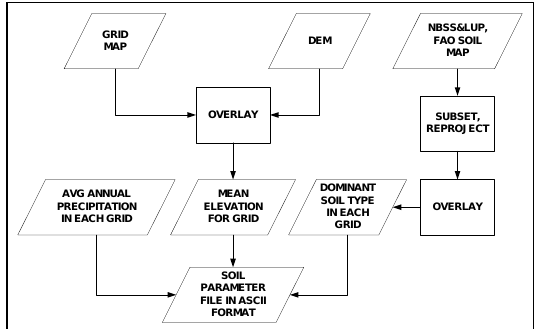
Figure 4 Flowchart to create soil parameter file